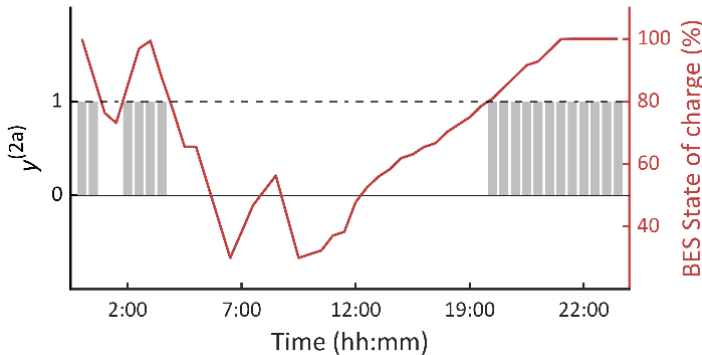
Figure 7. The value of the variable y ( 2 a ) and state of charge of the BES.